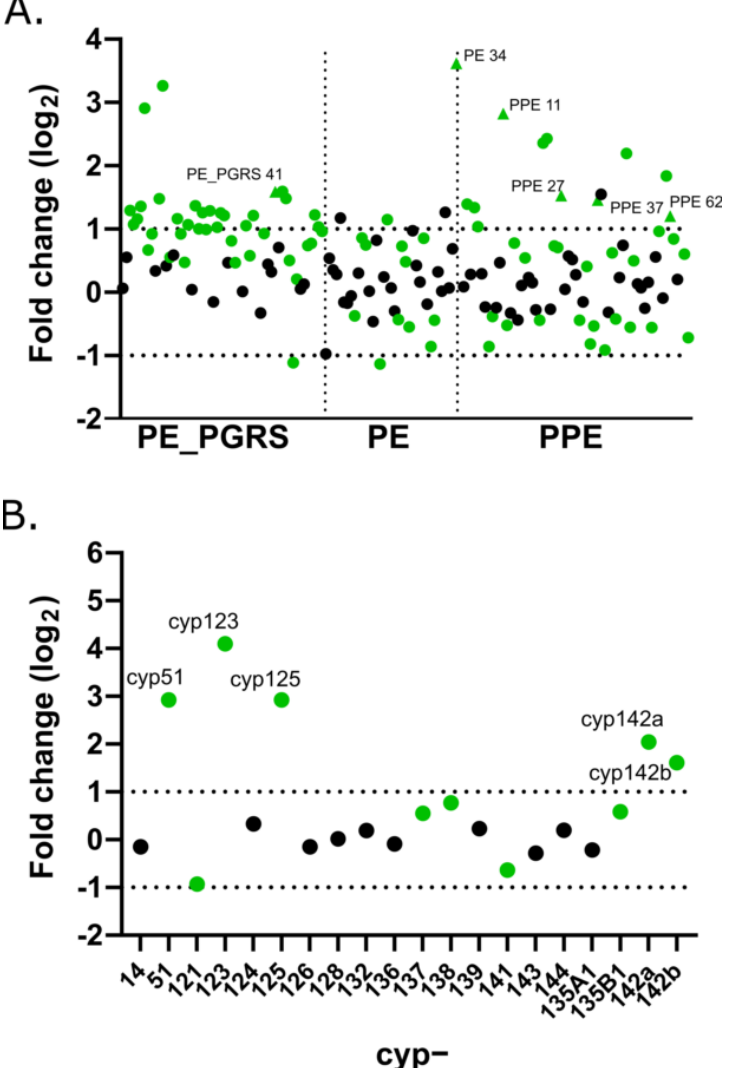
Figure 4. Intracellular gene expression levels of PE/PPE and cytochrome P450 families. Differential expression of the ( A ). PE/PPE/PE_PGRS families and ( B ). cytochrome P450 ( cyp ) family after 24 h macrophage infection compared to log phase in vitro bacilli. Triangles map to gene name labels in A. Green colour indicates corrected p -value < 0.05; horizontal dotted bars mark +1/ − 1 log2 fold change cutoffs.